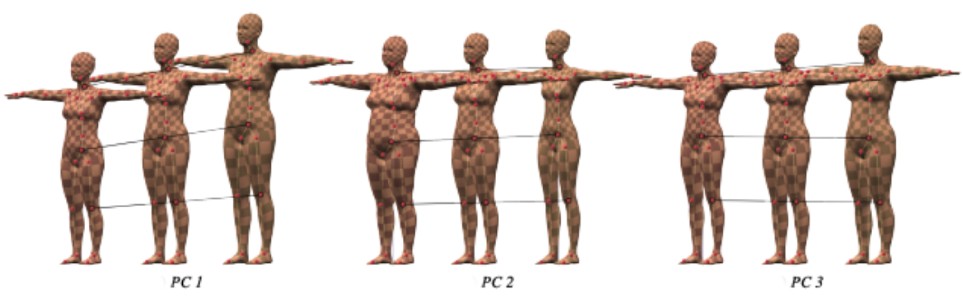
Figure 1. Example of the first 3 principal components of shape variations for the SMPL